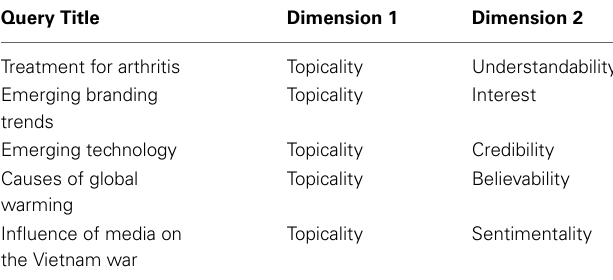
Table 1 | Queries and relevance